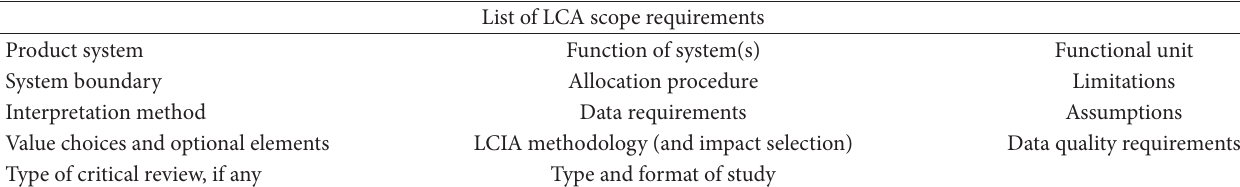
Table 2: Scope requirements of an LCA